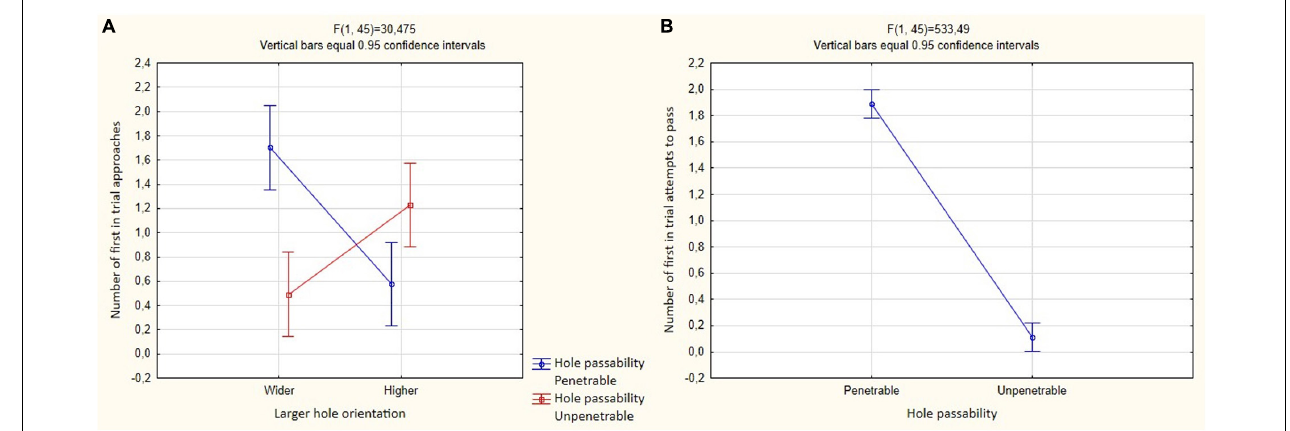
FIGURE 7 | Mean and 95% confidence intervals for the number of passes through holes in Experiment 2 of 12 test trials in both groups ( N = 5). (A) Mutual influence of predictors of hole passability and large hole orientation, dependent variable is the number of first approaches to the holes in the trial; (B) hole passability predictor, dependent variable is the number of first attempts to pass through the holes in the trial.